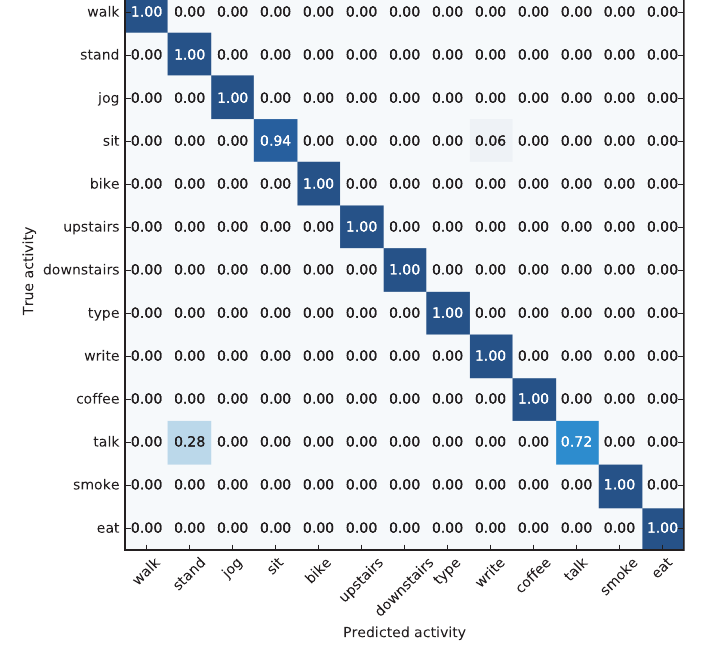
Figure 13. Confusion matrix for the most accurate